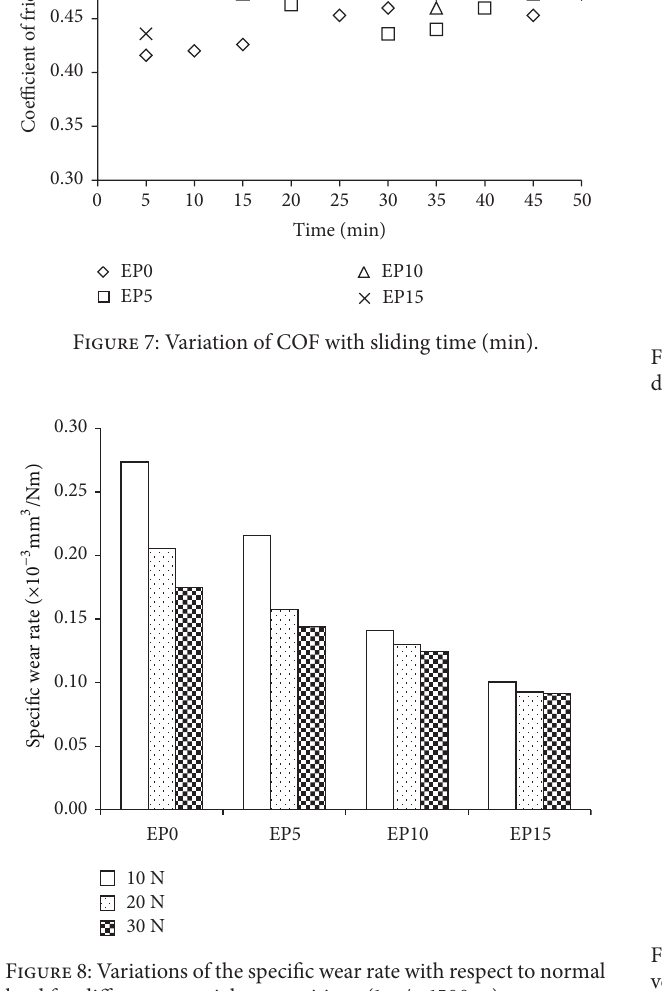
Figure 8: Variations of the specific wear rate with respect to normal load for different material compositions (1m/s, 1500 m).